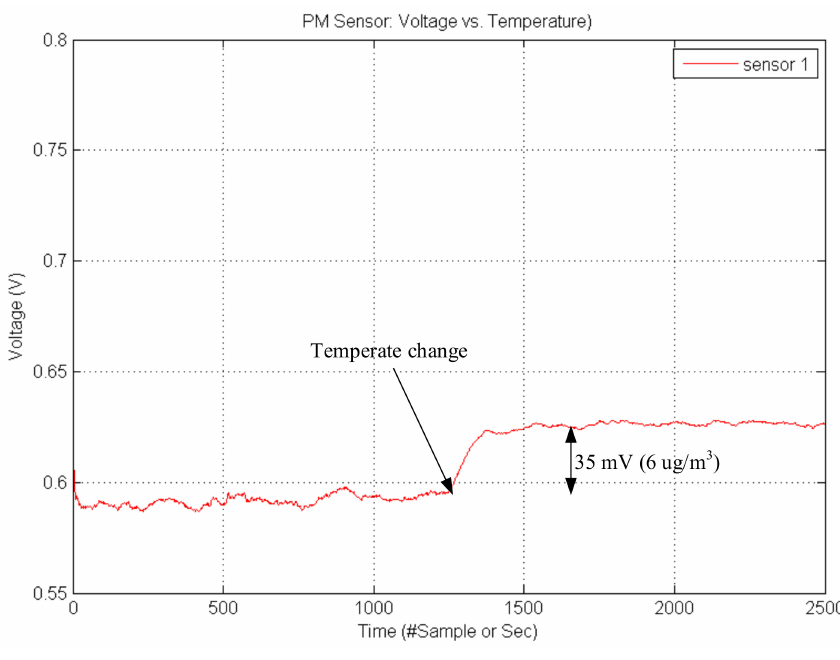
Figure 9. Temperature affection.